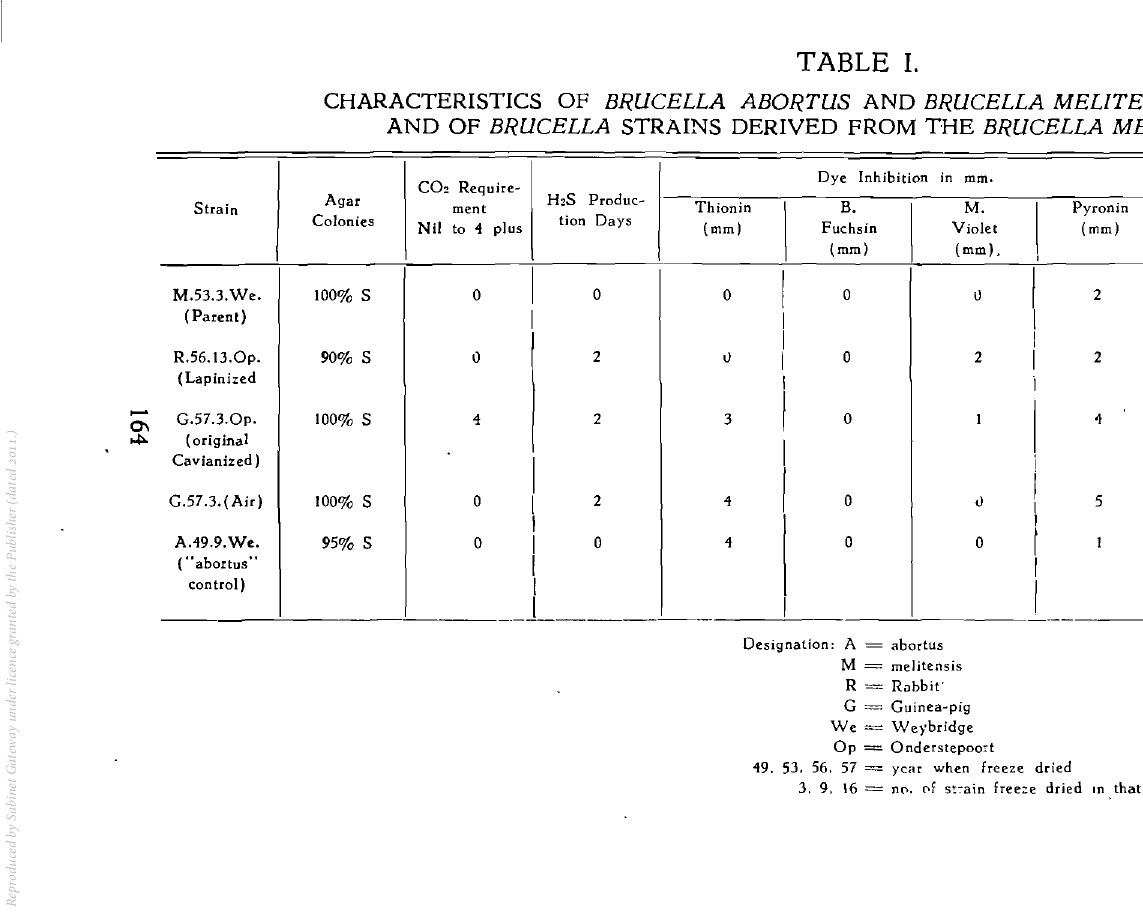
CHARACTERISTICS OF BRUCELLA ABORTUS AND BRUCELLA MELITENSIS STOCK STRAINS AND OF BRUCELLA STRAINS DERIVED FROM THE BRUCELLA MELITENSIS